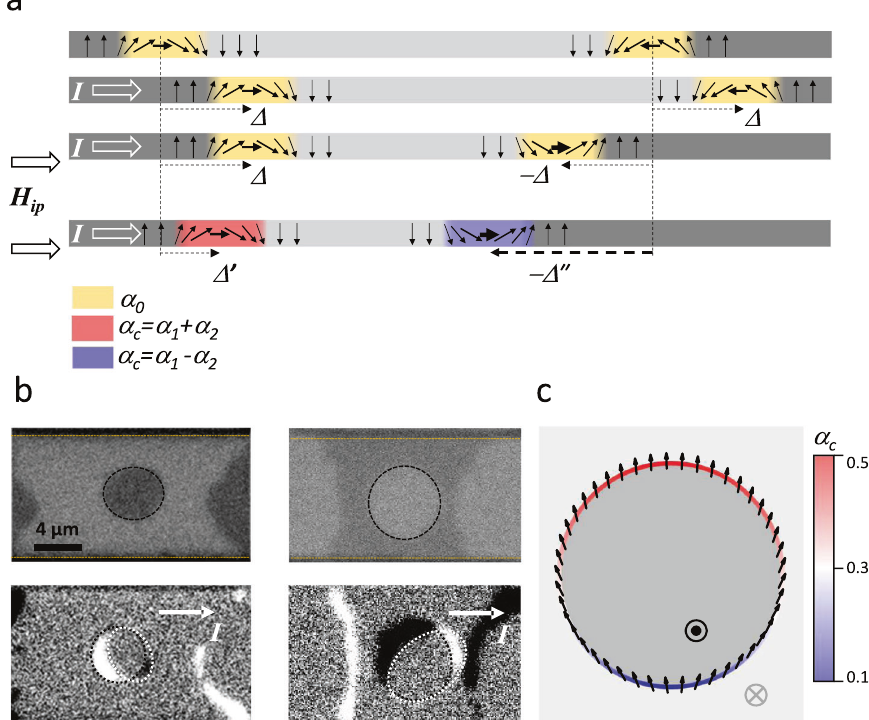
Fig. 1 Effect of chiral damping on the DW and SK dynamics. a . Schematic representation of current-induced motion of chiral DWs by SOT. The DWs with the same chirality (set by DMI) are displaced by the same amount ( Δ represented by the dotted arrows) and in the same direction by the current induced SOT. When an external in-plane fi eld sets the magnetization of the two DWs in the same direction, it imposes opposite chiralities. In this case, the two DWs still move by the same amount, but in opposite directions ( Δ and − Δ ). In the presence of chiral damping, the two DWs with different chirality experience different damping (red and blue). This engenders different mobility, which causes the different magnitude of the opposite displacements ( Δ ′ and − Δ ʺ ). b . Kerr images of magnetic bubble motion driven by electric current pulses (5000 · 20 ns at 1·10 12 A/cm 2 ) in Pt/Co/Pt tri-layers. The two initial states correspond to bubbles magnetized either up (top-left) or down (top-right). The black dotted lines are guides for the eye indicating the initial bubble position. The orange dotted lines indicate the lateral edge of the magnetic pad. As seen in the differential Kerr images (below), the bubbles are displaced along the direction of the electric current (white arrow), but also undergo a chiral distortion (from circular to elliptical; the orientation of the ellipse depends on the chirality). The white dotted lines indicate the fi nal state of the bubble. c . DW magnetization pro fi le (black arrows) along the bubble perimeter under the effect of DMI and horizontally applied electric current (H DMI = 200 mT; the damping-like and fi eld-like components of SOT are H FL = 33 mT and H DL = 66 mT). The dark/bright grey indicates the up/down magnetization. This image is to illustrate that as the chirality changes along the perimeter of the bubble, the value of the chiral damping (color scale) will also vary, leading to an angular-dependent DW